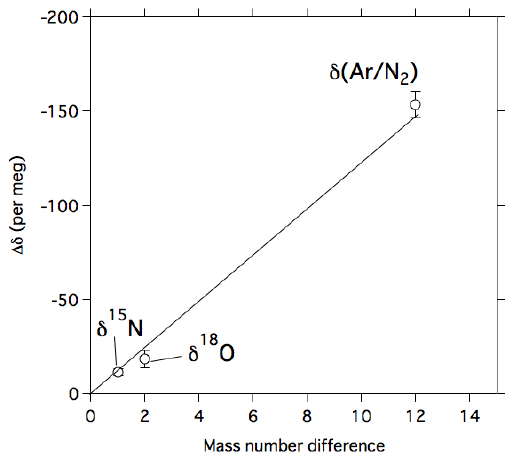
Figure 3. The relationship between the mass number difference and the (cid:49)δ value. The (cid:49)δ value denotes the difference in δ 15 N of N 2 , δ 18 O of O 2 , or δ( Ar / N 2 ) between 17.2 and 28.7km. The solid line represents a linear relationship between (cid:49)δ and the mass number difference.